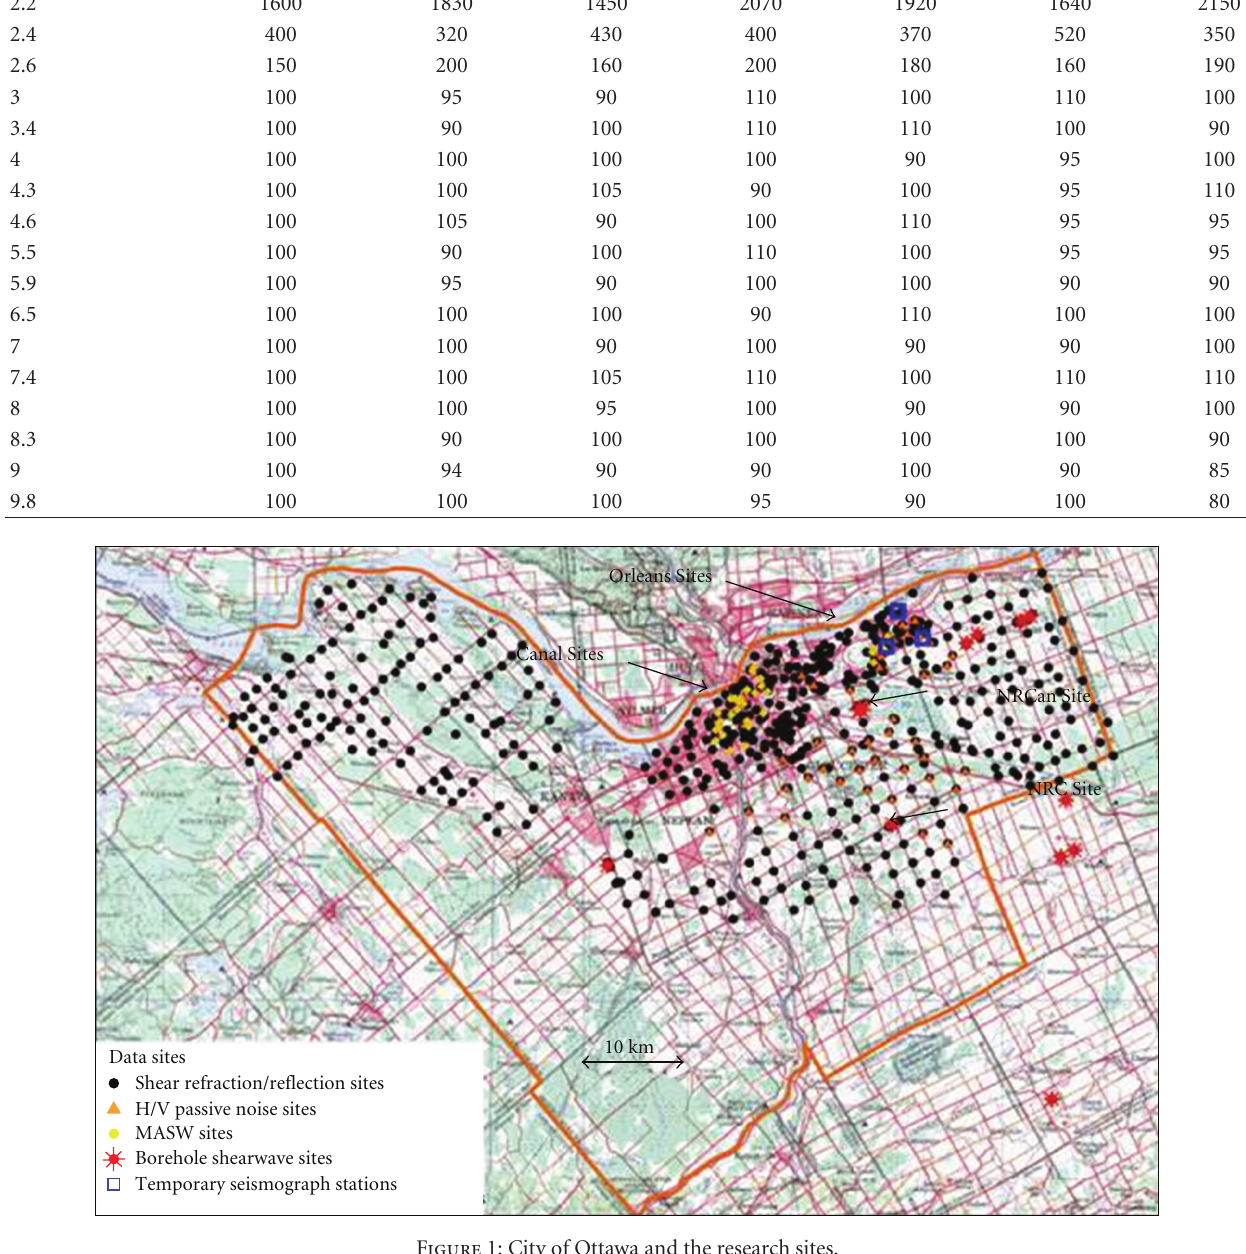
Table 2: Frequency-phase velocity ( V c in m/sec) of dispersion curves for soil profiles obtained in Figure 6. ( V c ) the extracted dispersion curve. ( V c ) the bedrock velocities of 1.4, 1.6, 1.8, 2.5, 2.8, and 3km/sec, respectively.